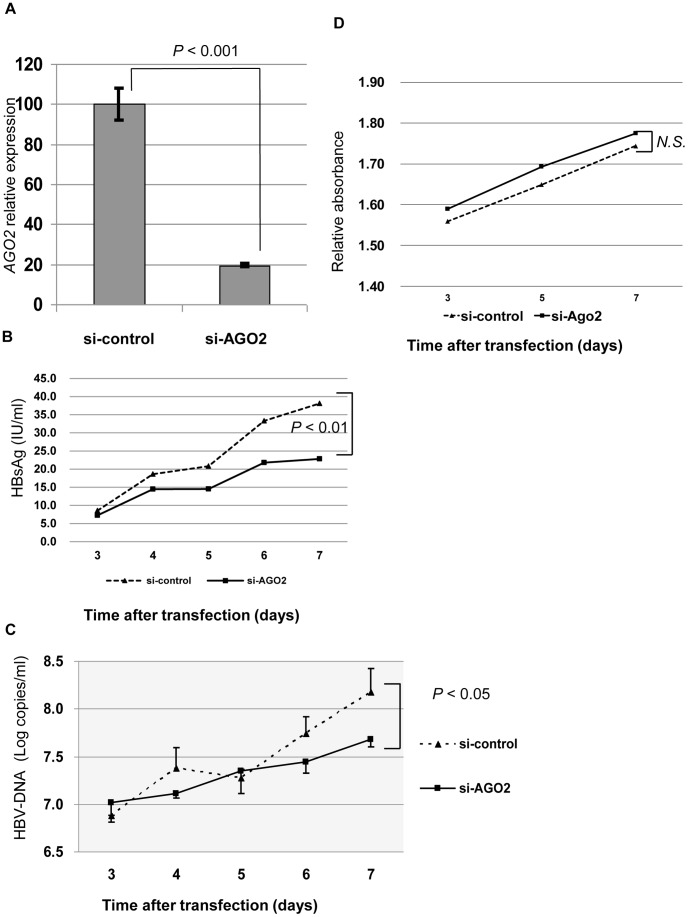
siRNA knock down of AGO2 expression.A) Knock down of AGO2 expression in T23 cells by specific siRNAs for AGO2 or control siRNAs, confirmed by real-time quantitative RT-PCR analysis. B) Supernatant HBs antigen, and C) HBV-DNA were measured. Both were higher in supernatant of cells transfected with si-control than in cells transfected with si-AGO2. D) There was no significant difference in cell viability between cells transfected with si-control compared to those with si-AGO2.